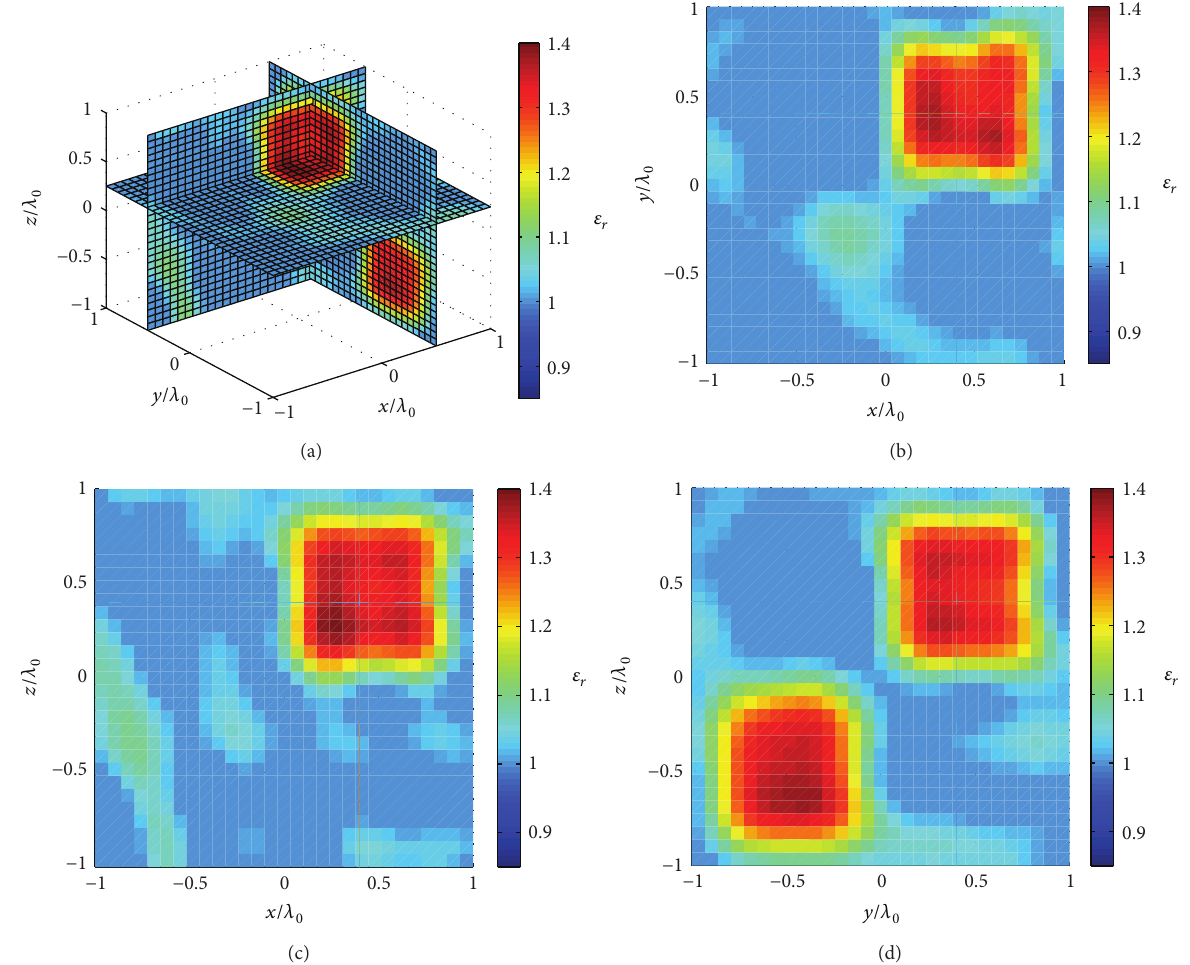
Figure 5: Reconstructed distribution of the relative dielectric permittivity. (a) 3D view; (b) 𝑥𝑦 plane ( 𝑧 = 0.4𝜆 0 ); (c) 𝑥𝑧 plane ( 𝑦 = 0.4𝜆 0 ); (d) 𝑦𝑧 plane ( 𝑥 = 0.4𝜆 0 ). Two separate objects. SNR = 25 dB. 𝐿 = 2